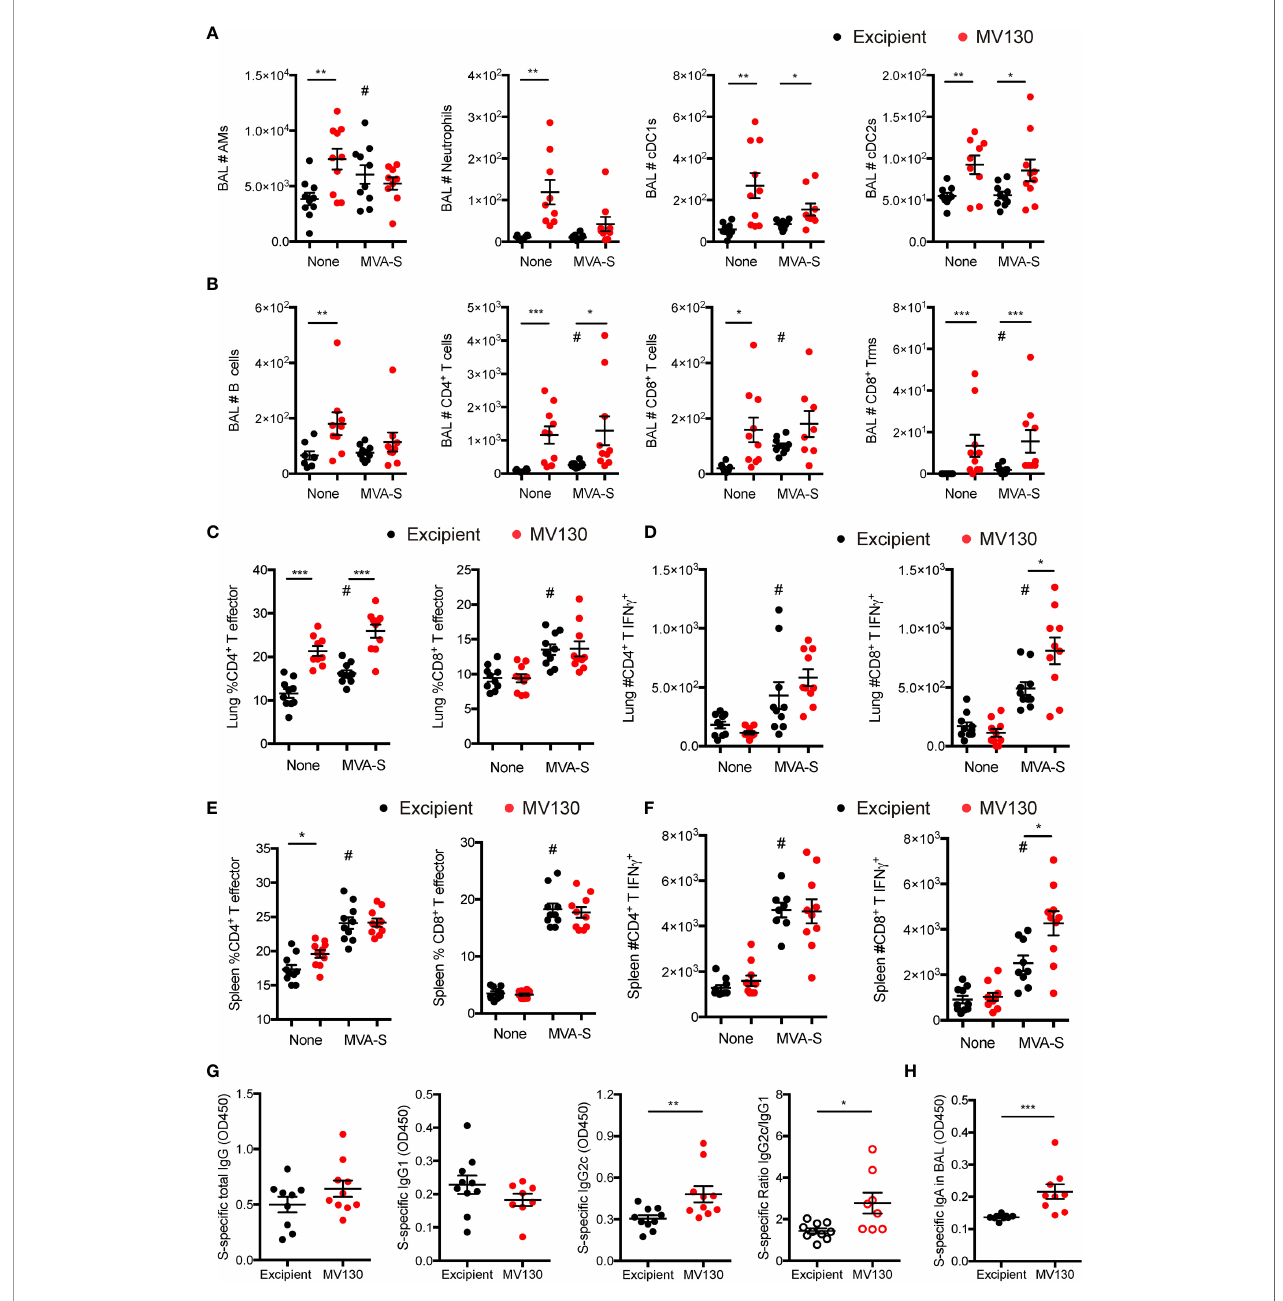
FIGURE 2 | MV130 increases immunogenicity of an MVA-based COVID-19 vaccine candidate. Three weeks after receiving excipient or MV130 according to Figure 1A , C57BL/6 mice were i.m. vaccinated with a COVID-19 vaccine based on a Modi fi ed Vaccinia virus Ankara (MVA) vector expressing the entire SARS-CoV-2 Spike (S) protein. Samples were collected 10 days later. (A, B) Bronchoalveolar lavage (BAL) was obtained from excipient and MV130-treated mice. Quantitative analysis of different myeloid (A) or lymphoid (B) immune populations identi fi ed by FACS. AMs, alveolar macrophages; cDC1s, type 1 conventional dendritic cells; cDC2s, type 2 conventional dendritic cells. (C, D) Lungs were recovered, and the effector phenotype (CD44 + ) of CD4 + and CD8 + T cells was analyzed (C) . SARS-CoV-2 S protein-speci fi c activation of CD4 + and CD8 + T cells was assessed by analyzing intracellular IFN g expression by FACS (D) as described in Methods . (E, F) The effector phenotype (E) and SARS-CoV-2 S protein- speci fi c activation (F) of T cells from the spleen were analyzed, as in (C, D) . (G) Levels of SARS-CoV-2 S protein-speci fi c total IgG, IgG1, IgG2c, and the ratio of IgG2c/IgG1 were analyzed in serum of vaccinated mice. Data correspond to values from sera diluted at 1/250. (H) Levels of SARS-CoV-2 S protein-speci fi c mucosal IgA were analyzed in the BAL of vaccinated mice. Data correspond to values from BAL diluted at 1/1. (A – H) Data shown as mean ± SEM. N=2. *p < 0.05; **p < 0.01; ***p < 0.001, Student ’ s t test comparing excipient versus MV130. (A – F) # p < 0.05 comparing non-vaccinated versus MVA-S vaccinated conditions. (G, H) OD, optical